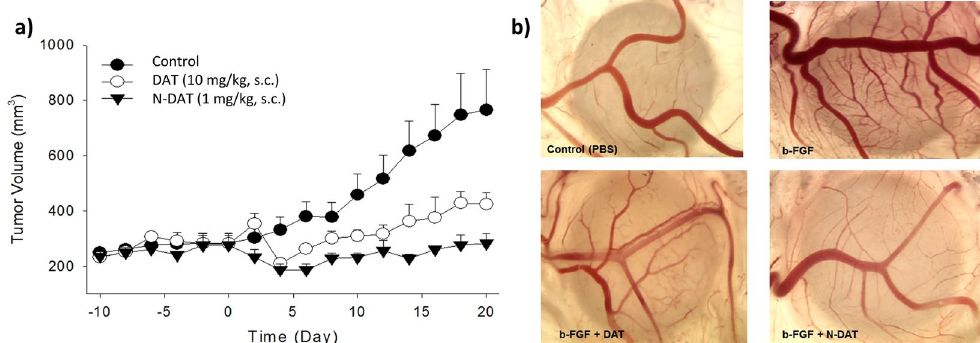
Figure 10. ( a ) NDAT administered daily for 20 days at 1 mg/kg subcutaneously (s.c.) resulted in greater tumor volume suppression versus DAT administered daily for 20 days at 10 mg/kg, s.c. ( b ) Images for suppression of b-FGF-induced angiogenesis in the chick chorioallantoic membrane (CAM) model by DAT versus NDAT at 500 ng/CAM. Data illustrate greater anti-angiogenesis efficacy of NDAT versus DAT at the same concentration.